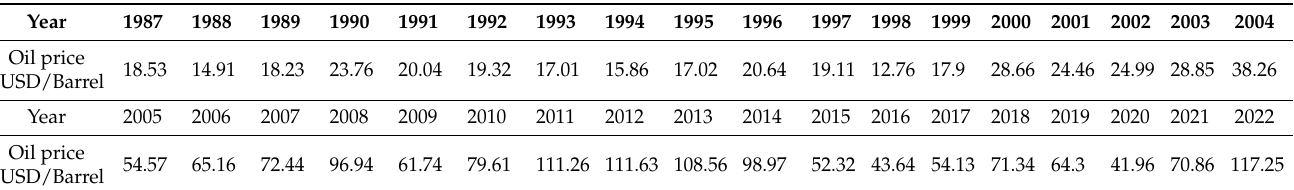
Table 1. Statistical data used for this model.